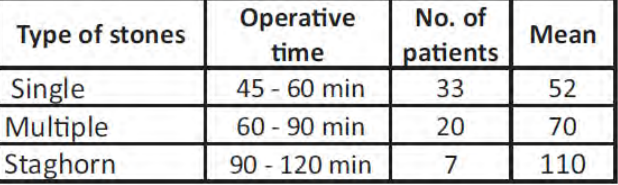
Table 4. Duration of operation for different types of